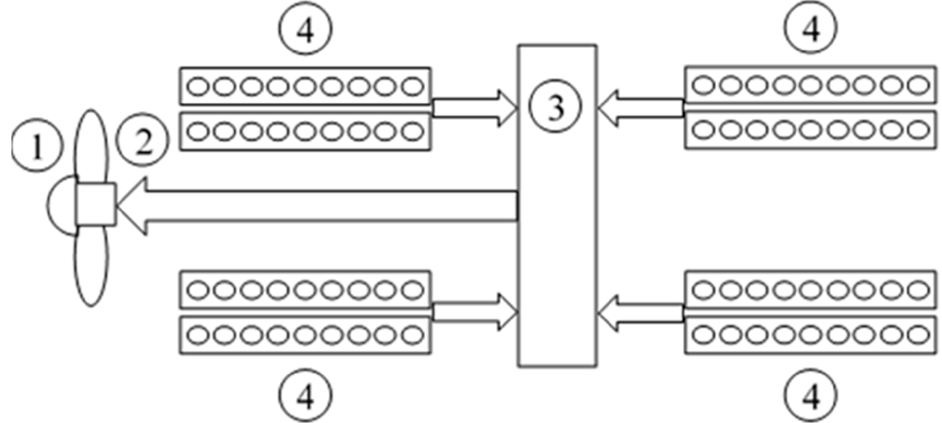
9 of 18 Figure 5. Propulsion with three medium-speed diesel engines (Legend: 1—propeller, 2—propeller shaft, 3—gearbox, 4—four-stroke diesel engine). In this case, the engine load is 33.7% of MCR at a navigation speed of 12 knots. This con fi guration provides very good adaptability to the wide range of navigation speeds and high reliability of the propulsion system. However, due to the losses in mechanical power transmission and the lower e ffi ciency of four-stroke diesel engines compared with two- stroke diesel engines, the fuel consumption is higher. The basic characteristics of the medium-speed marine diesel engine MAN 12V48/60CR used in the third con fi guration are listed in Table 7. Table 7. Basic characteristics of a medium-speed diesel engine MAN 12V48/60CR (Data from [37]). Characteristics Value Bore